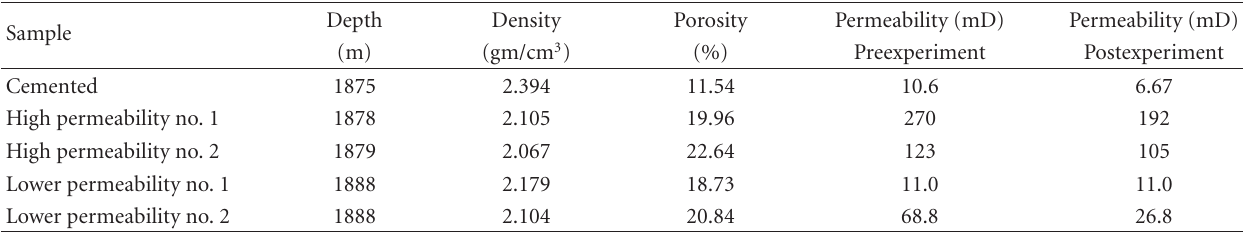
Table 1: Depth, density, porosity, and permeability of core samples from three di ff erent lithological zones.